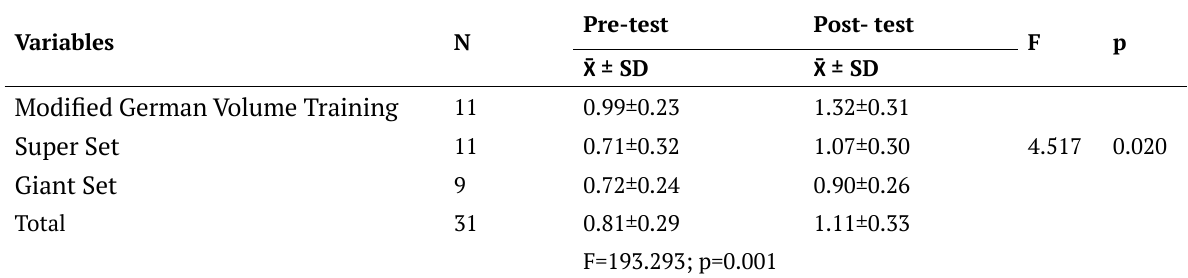
Table 10. Pre-test and post-test comparison of shoulder press values of the groups